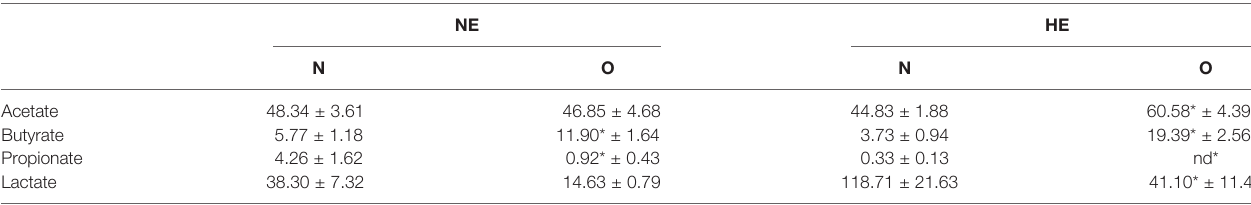
Data are expressed as mean ± standard deviation; for a given energy medium, * denotes signi fi cant differences (p<0.05) in the production of SCFAs and lactate between the two microbiotas (N and O); nd, not